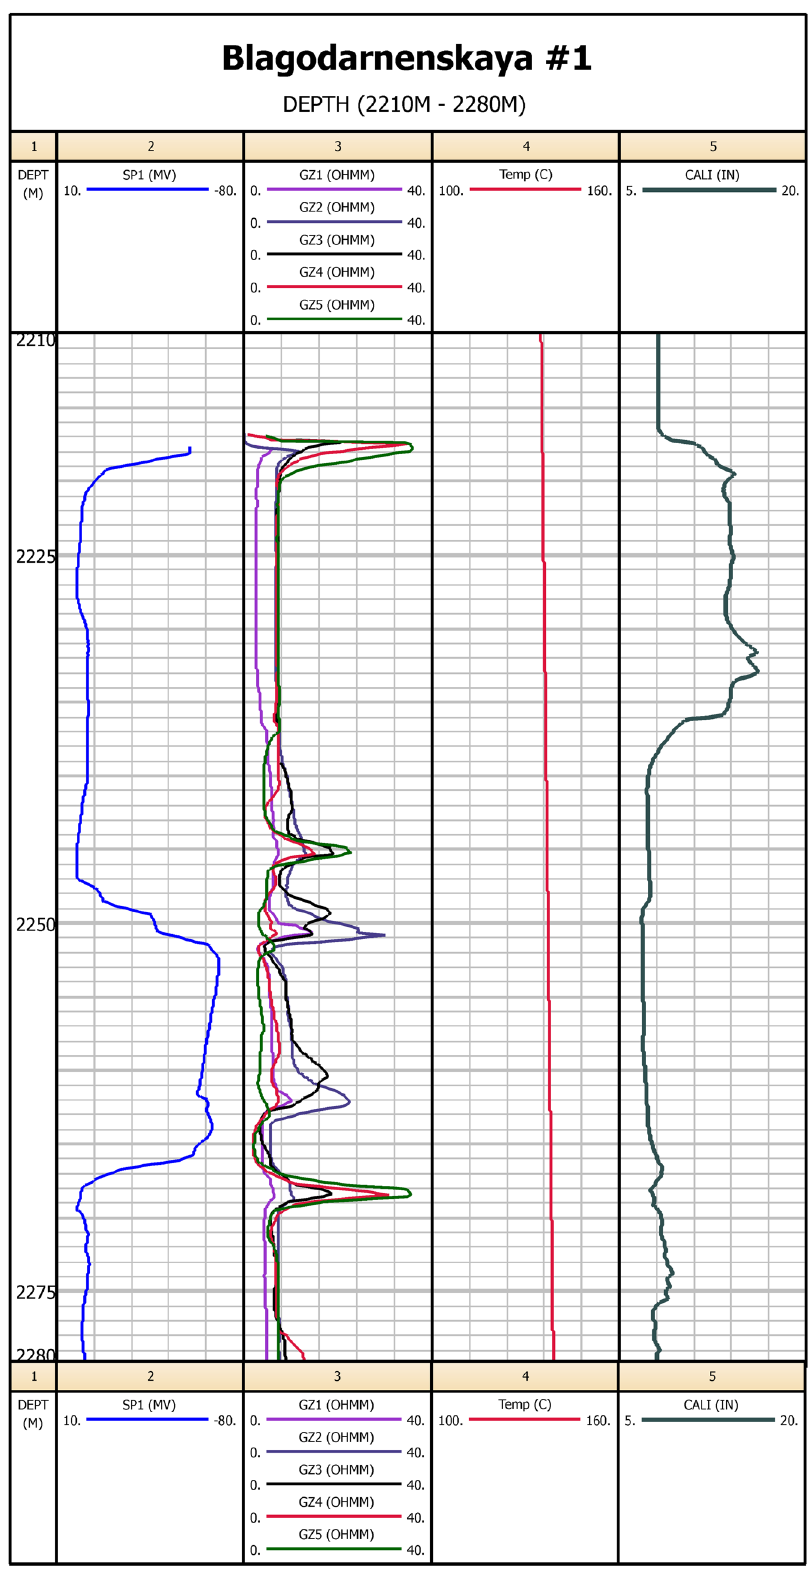
Fig. 6 Wireline logs for the Well # 1